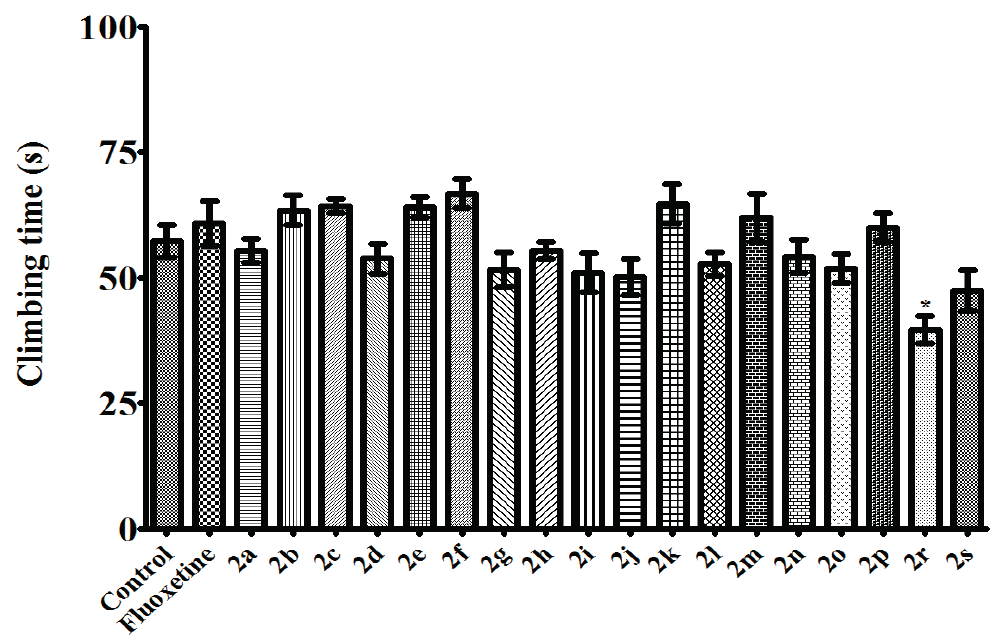
Figure 4. Effects of test compounds (100 mg/kg) and fluoxetine (10 mg/kg) on climbing time of mice in MFST. Significance against control values * p < 0.05. Values are given as mean ± SEM. One-way ANOVA, post-hoc Tukey’s test, n =